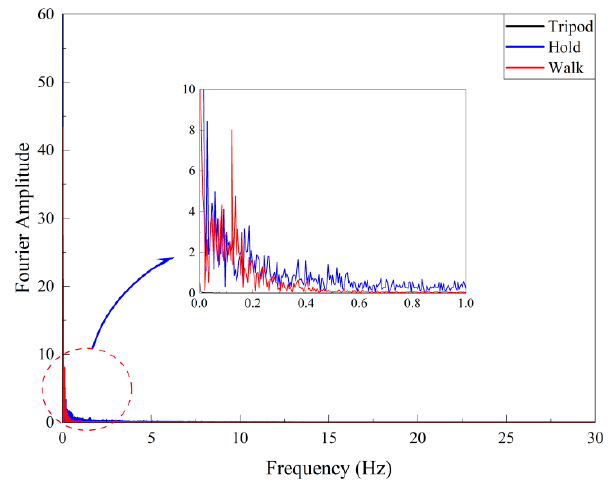
Figure 12. Frequency domain comparison of three shooting states using smartphone.